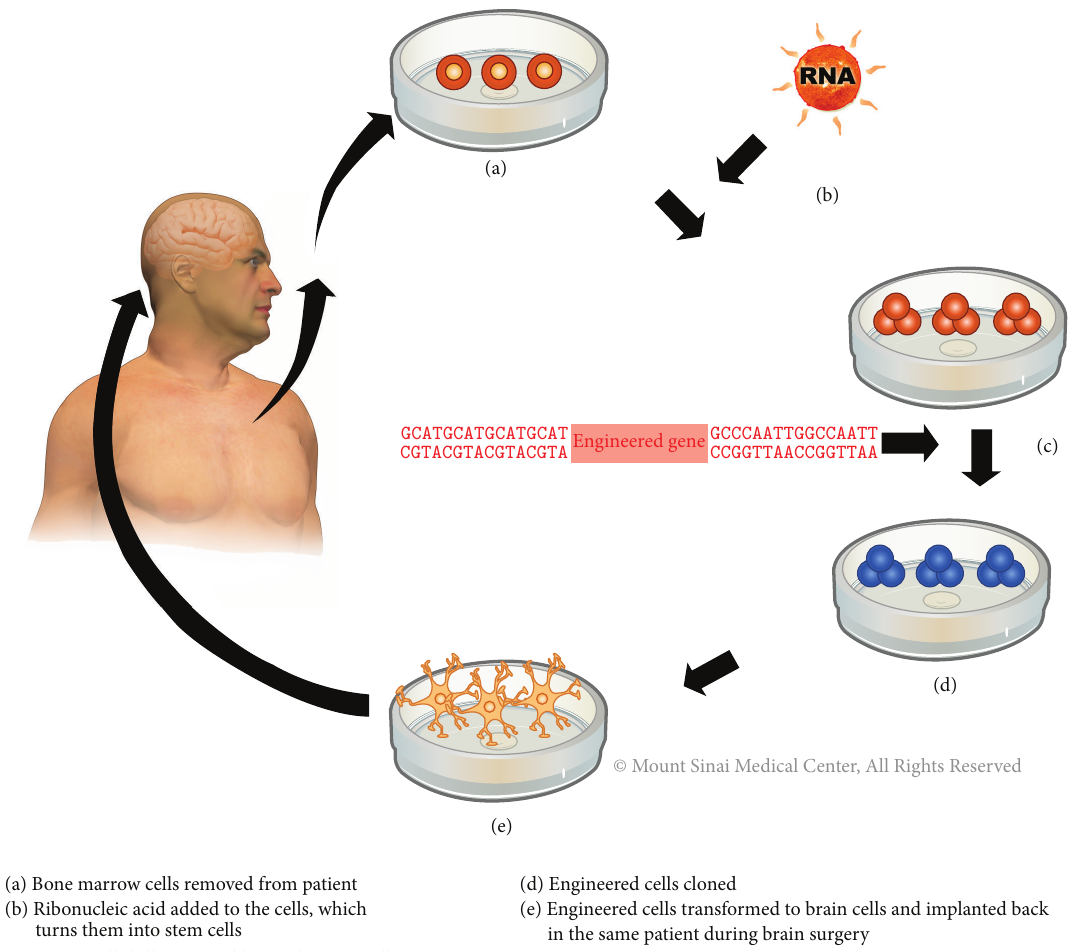
Figure 4: Personalized medicine using patient-specific iPSC. Diagrammatic summary of reprogramming patient-specific cells into footprint- free hiPSC, engineering their DNA to carry proapoptotic genes, differentiating them into astrocytes, and reimplanting them at the time of surgery for brain tumor recurrence. (a) Dermal fibroblast cells obtained from patient. (b) Ribonucleic acid (RNA) added to cells, which turns them into stem cells. (c) Tumor cells killer gene added to stem cells. (d) Engineered cells cloned. (e) Engineered cells transformed to brain cells, astrocytes, and implanted back in the same patient at the time of surgical resection for recurrent